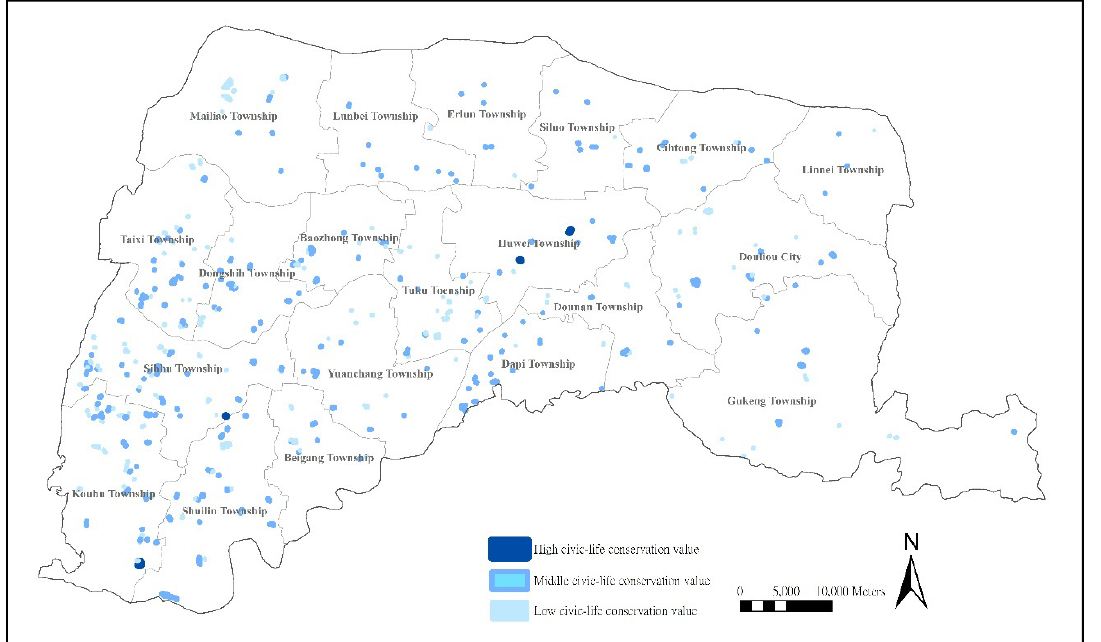
Figure 3. Distribution of farm ponds with civic life preservation